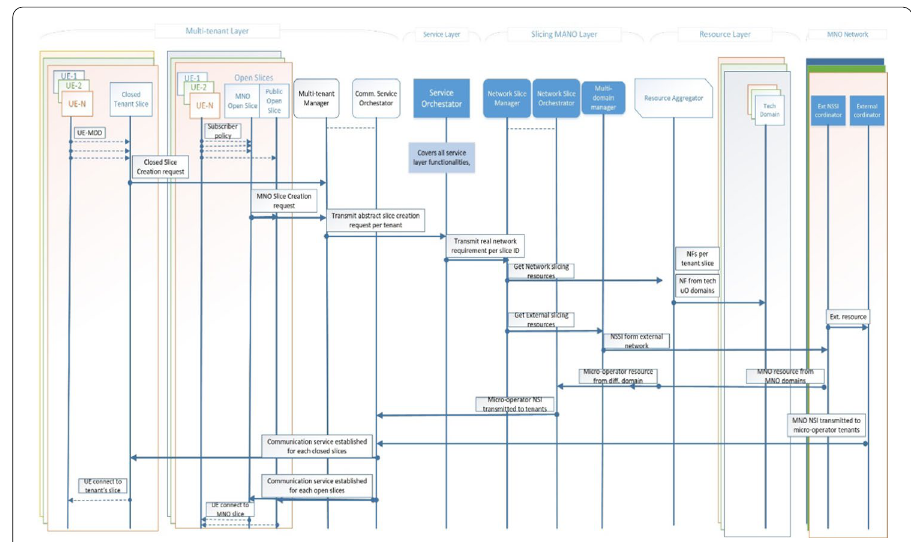
Fig. 7 End‑to‑end message sequence diagram for a micro‑operator network slicing architecture. This figure presents a step by step sequence of achieving network slicing in a micro‑operator based on the presented